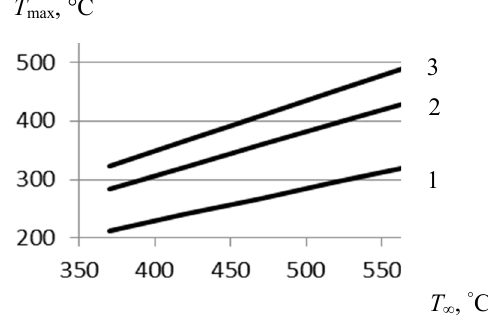
Fig. 5. Dependence of the maximum temperature Т max on Т ∞ at heating time t heat : 1 – 0.8 s; 2 – 1.2 s; 3 – 2.0 s.